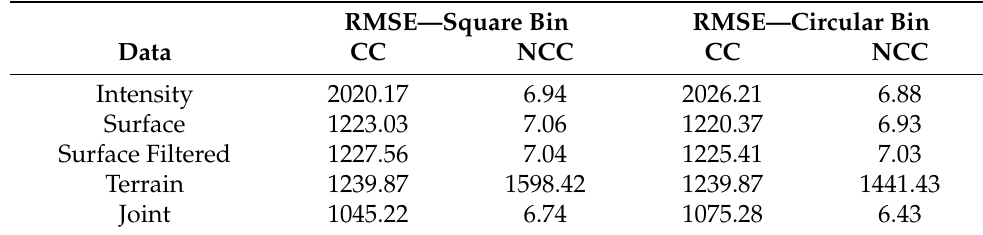
Table 2. Root mean square errors of Cross-correlation and Normalized Cross-correlation, for square and circular binning, converted from pixel units to meters.